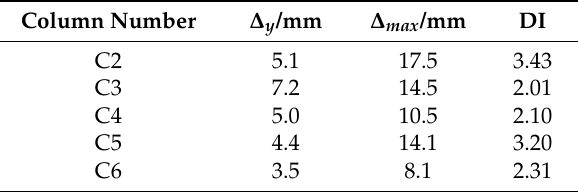
Table 5. Comparison of ductility of